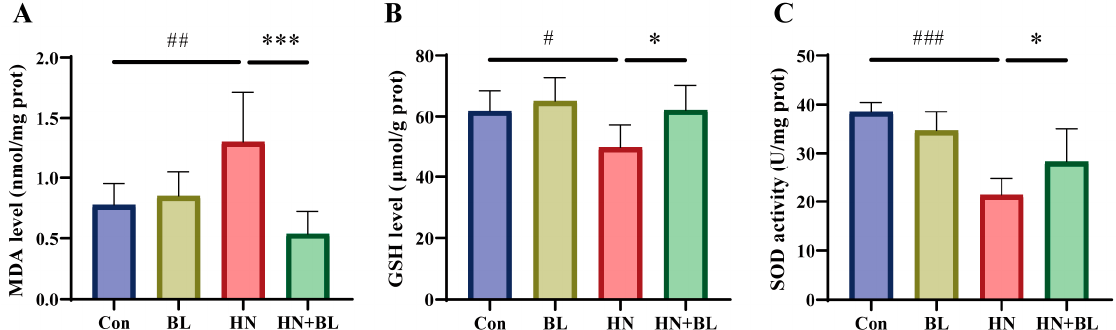
Figure 4. Effects of BL on oxidative stress in the kidneys of mice with HN. The levels of MDA ( A ), GSH ( B ), and SOD activity ( C ) in the kidneys. Data represent mean ± SD ( n = 6). # p < 0.05, ## p < 0.01, ### p < 0.001 vs. the Con group; * p < 0.05, *** p < 0.001 vs. the HN group.